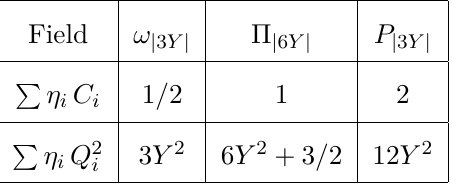
and P η for some possible new SM representations. i C i i